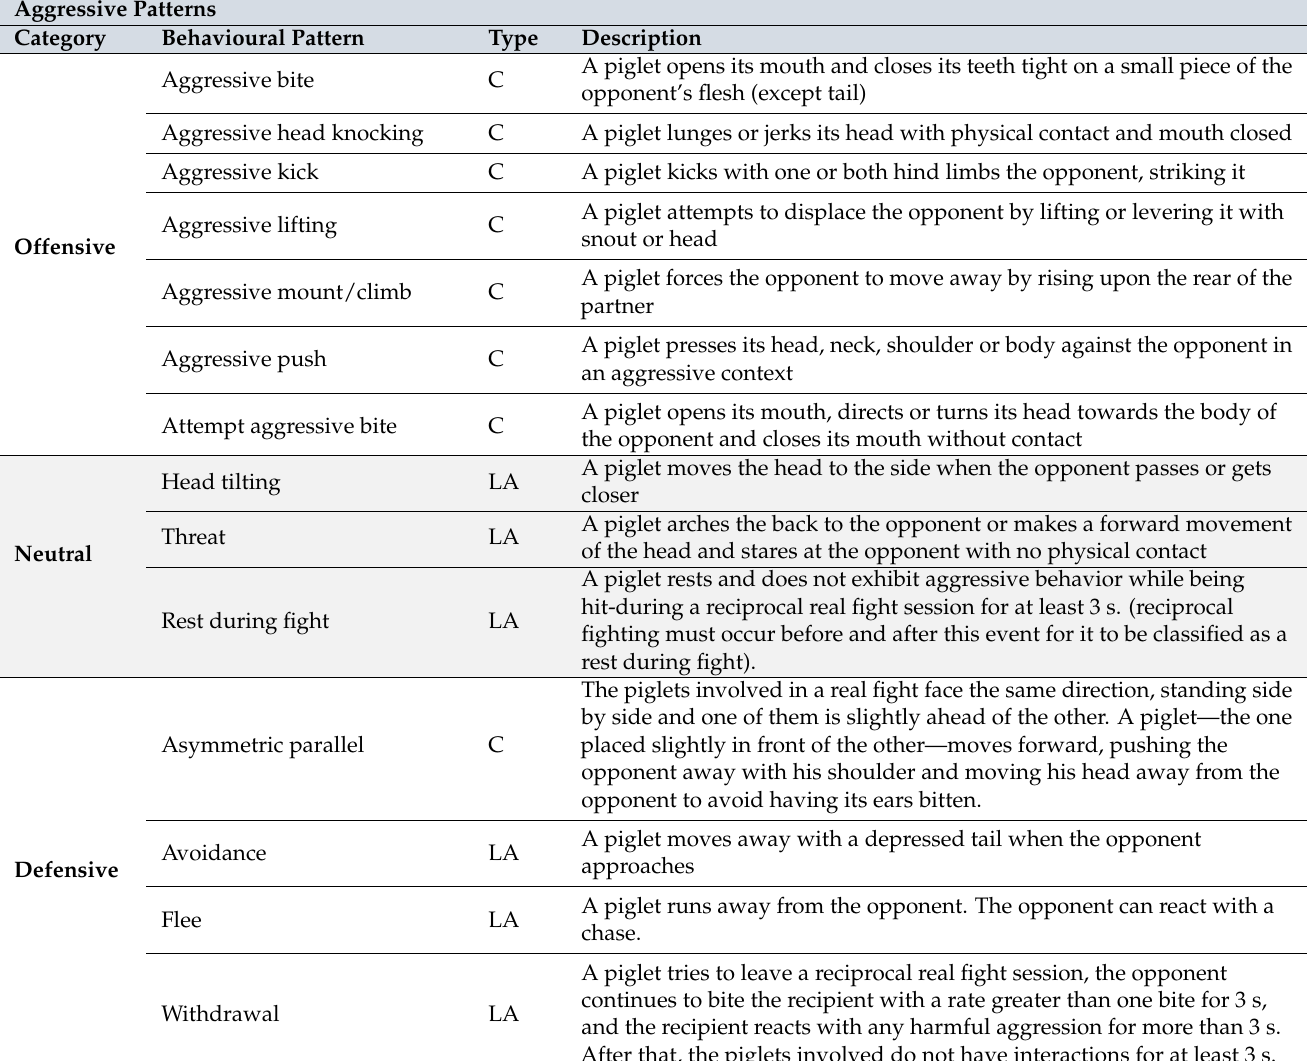
Table 3. Ethogram with aggressive patterns recorded in the current